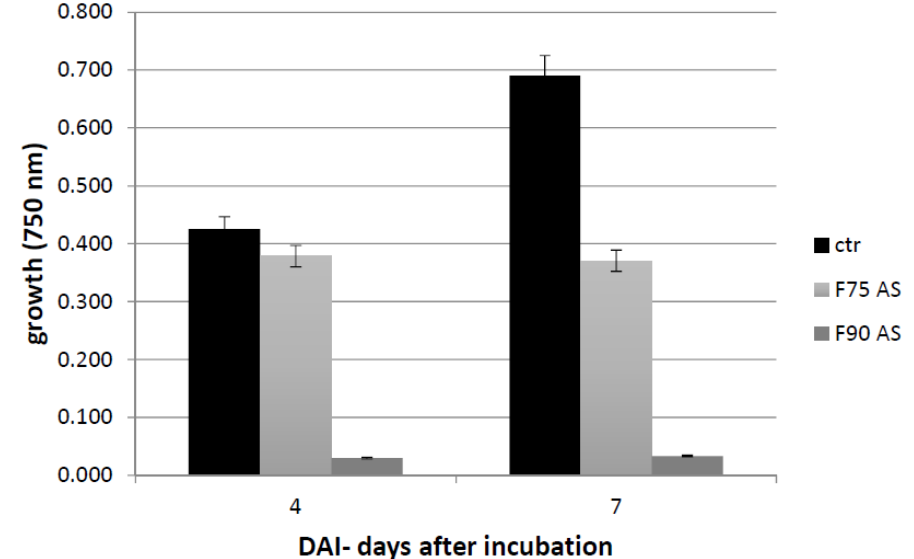
Figure 3. Fungal growth (absorbance at 750 nm) assayed by Biolog FF microplate, after 4 and 7 dai at 25 °C in presence (F75 AS and F90 AS) and in the absence (ctr) of protein fractions. The results are the mean ± SD of 3 different experiments.